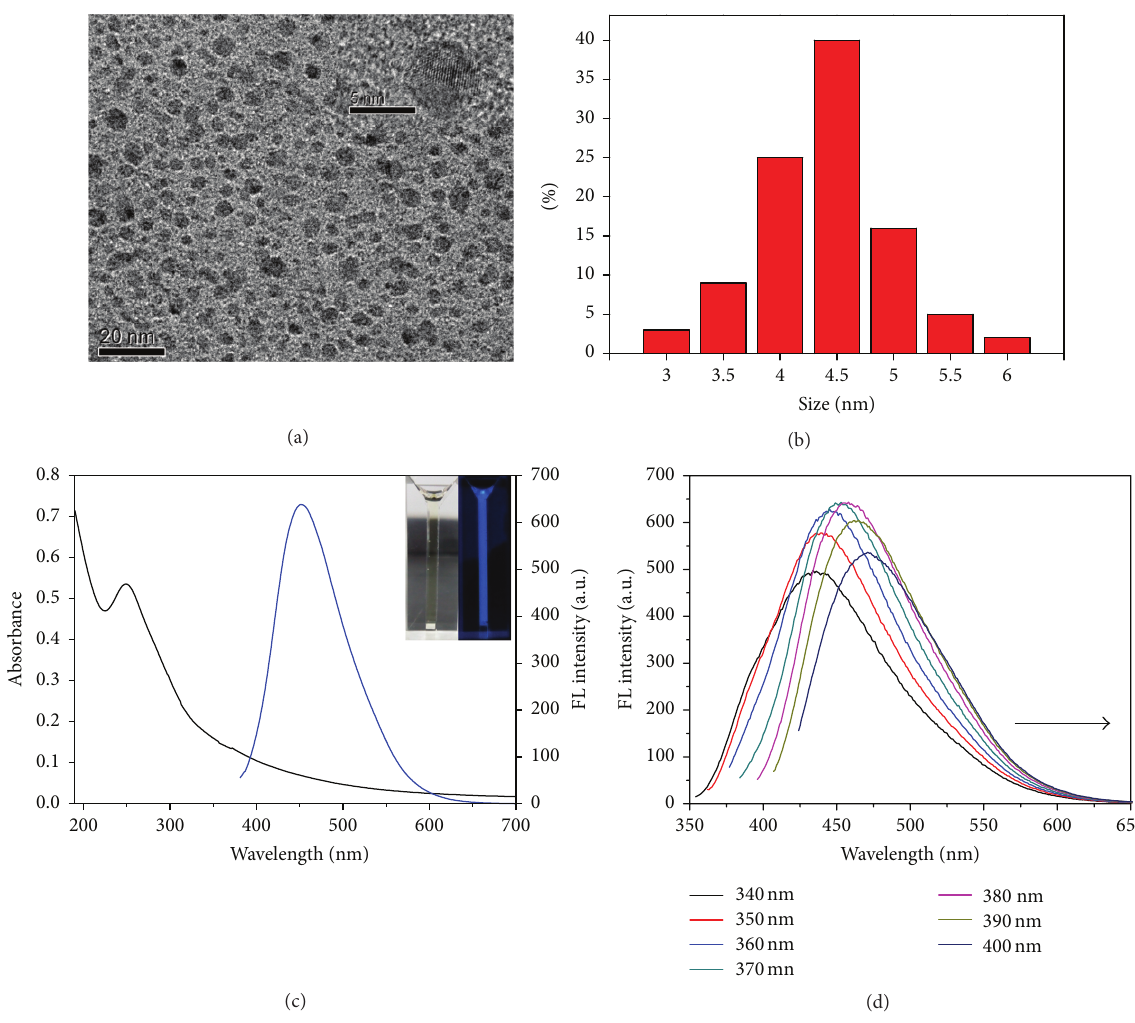
Figure 1: TEM image (a) and size distribution (b) of CDs. (c) UV-Vis absorption spectrum and FL intensity spectrum of CDs (inset shows the photographs of CDs under day light and ultraviolet light). (d) FL emission spectra (with progressively longer excitation wavelengths from 340 to 400 nm) of